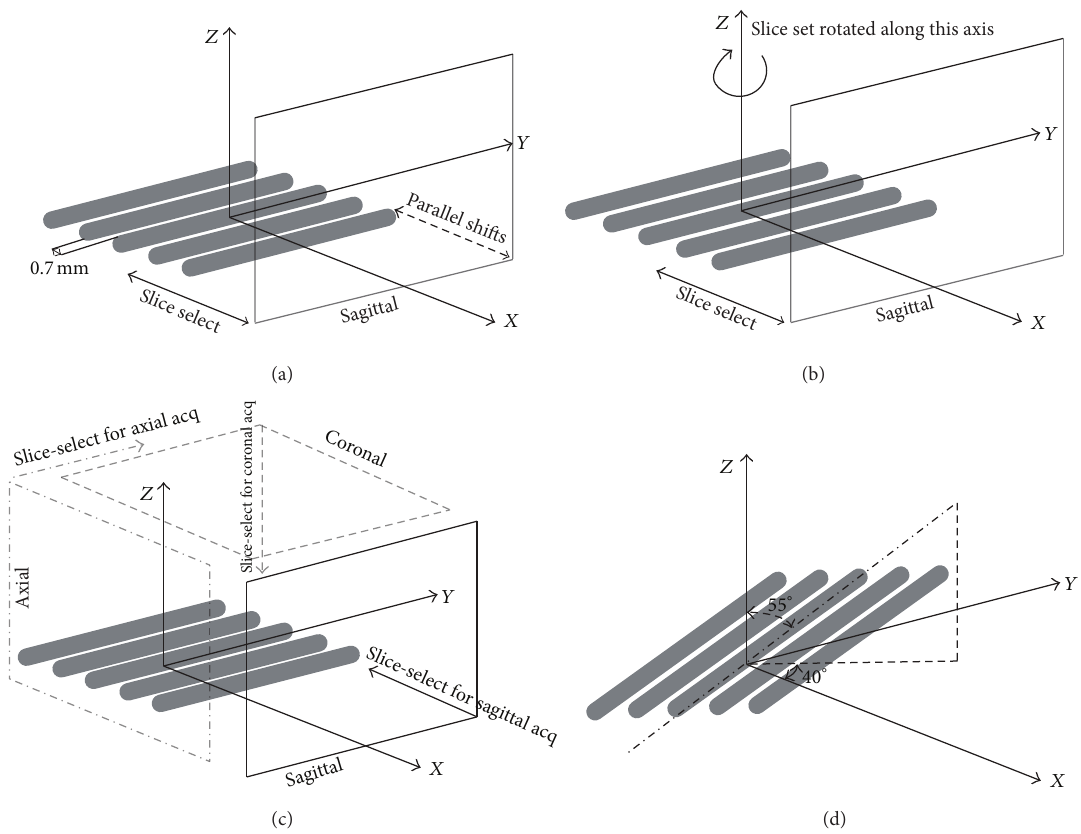
Figure 2: Schematic illustrating the orientation of the resolution phantom where the long axis of tubes were positioned orthogonally to the slice-select direction of the (a) shifted, (b) rotational, (c) orthogonal acquisition geometries, and (d) orientation of tubes in the resolution phantom for the oblique setup and the acquisition geometries shown in Figures 2(a), 2(b), and 2(c) were repeated for this oblique orientation. (Axes in this image represent physical coordinates and the main magnetic field is in Z